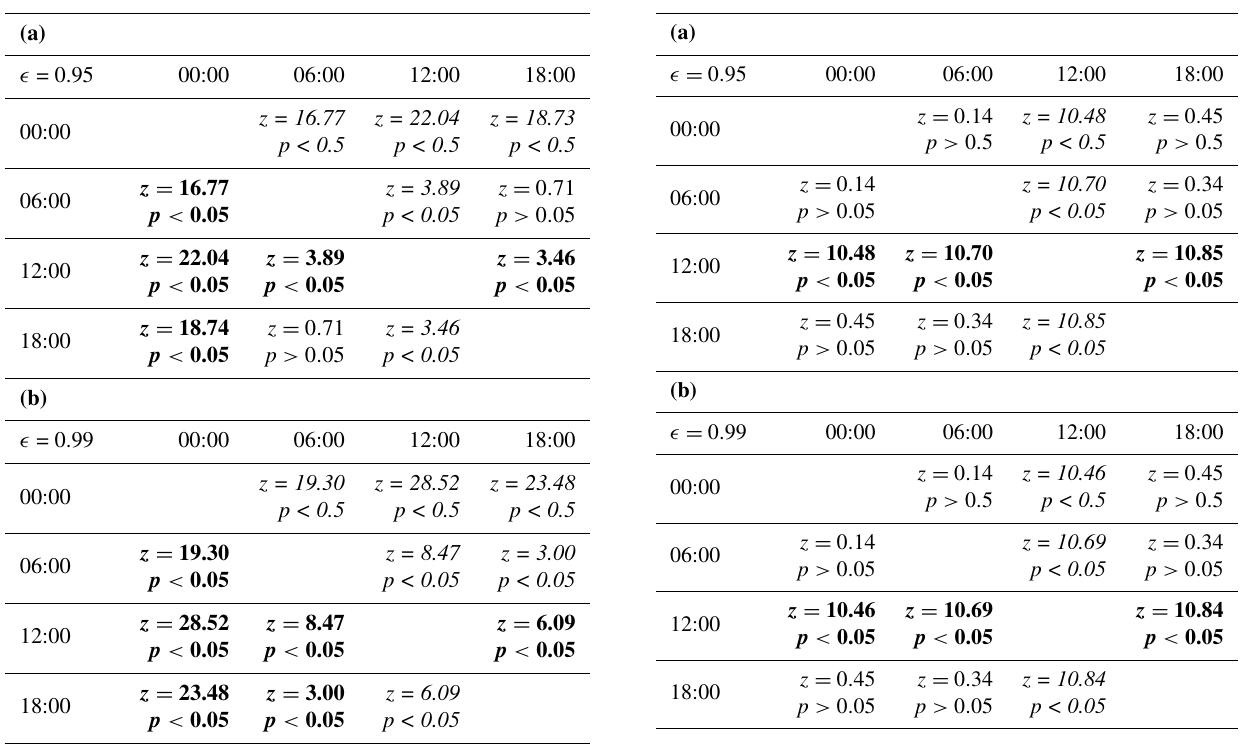
Table 6. Results for Wilcoxon rank sum tests between modeled temperature inversions at 00:00, 06:00, 12:00, and 18:00 during the summer using an emissivity value of (a) (cid:15) = 0 . 95 and (b) (cid:15) = 0 . 99. Inversions ( T surface − T air ) were calculated from ERA5 and Divide AWS data. Bolded cells indicate a larger inversion in the column hour; italicized cells indicate a larger inversion in the row hour; and standard-font cells indicate no significant difference between the hours.